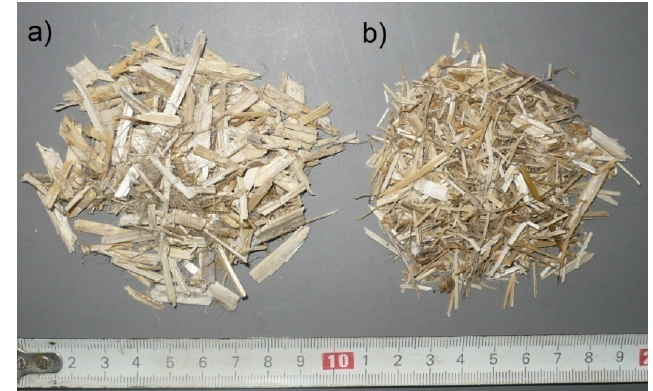
Figure 1. Fillers used for composites: ( a ) hemp shives; and ( b ) flax straw.